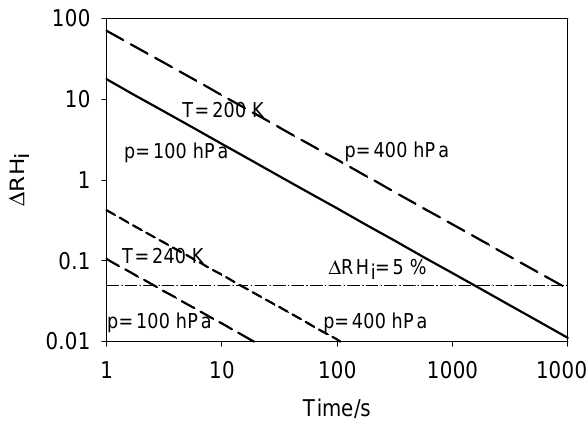
Fig. A4. Relative humidity increase over ice due to engine water vapor emissions versus time for four combinations of ambient pres- sure and temperature. The 5 % change is high-lighted by a horizon-